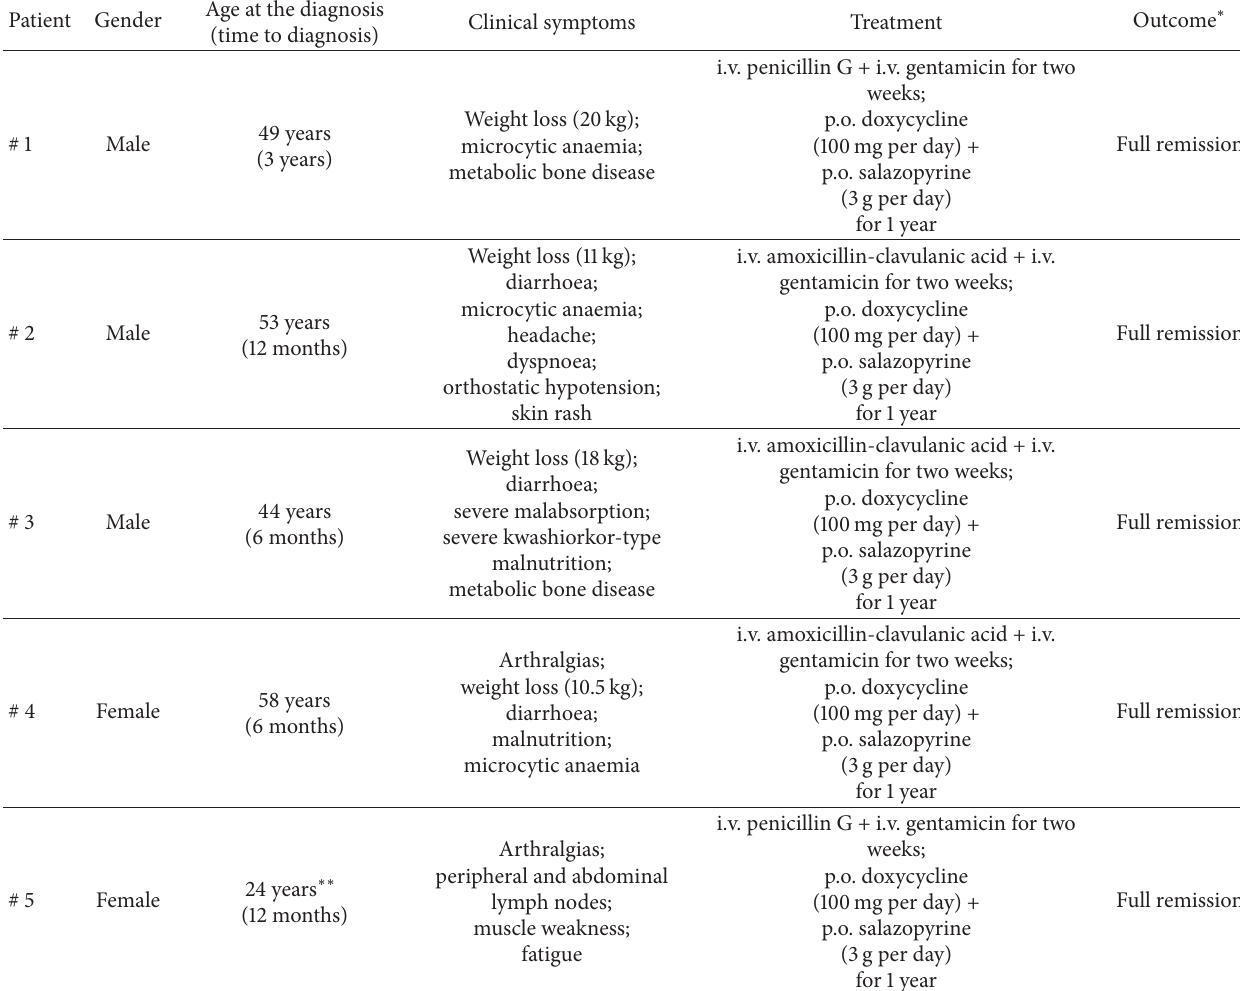
Table 1: Characteristics of five patients with Whipple’s disease diagnosed in the period